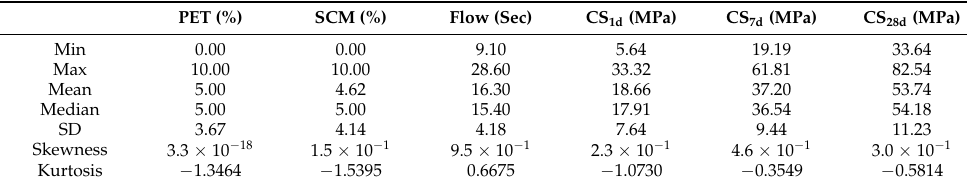
Table 4. Statistical evaluation of input and output